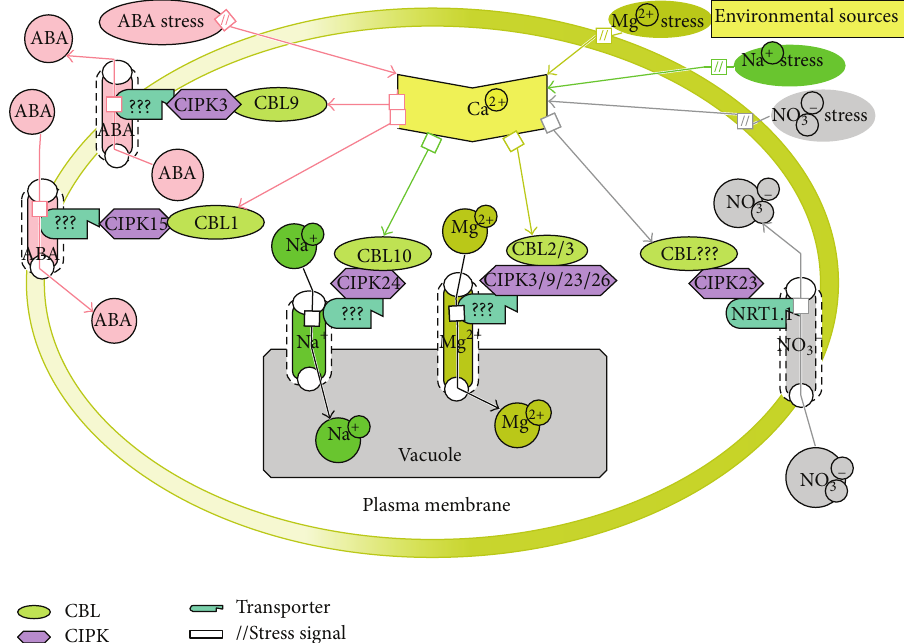
Figure 2: This model represents partially identified CBLs-CIPKs signalling system. Here, question marks (???) indicate that components have not yet been identified. Different colors indicate different pathways. NRT1.1: nitrate transporter